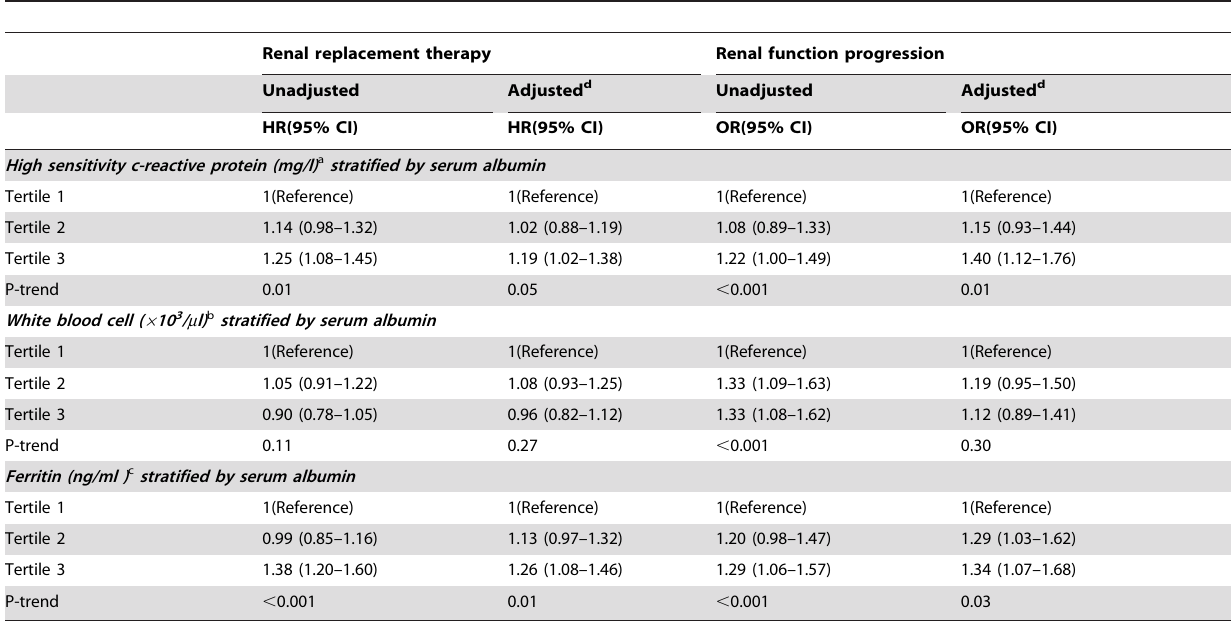
Abbreviations: HR, Hazard Ratio; OR, Odds Ratio; CI, Confidence Interval. a High sensitivity C-reactive protein tertile cut at 0.5, 3